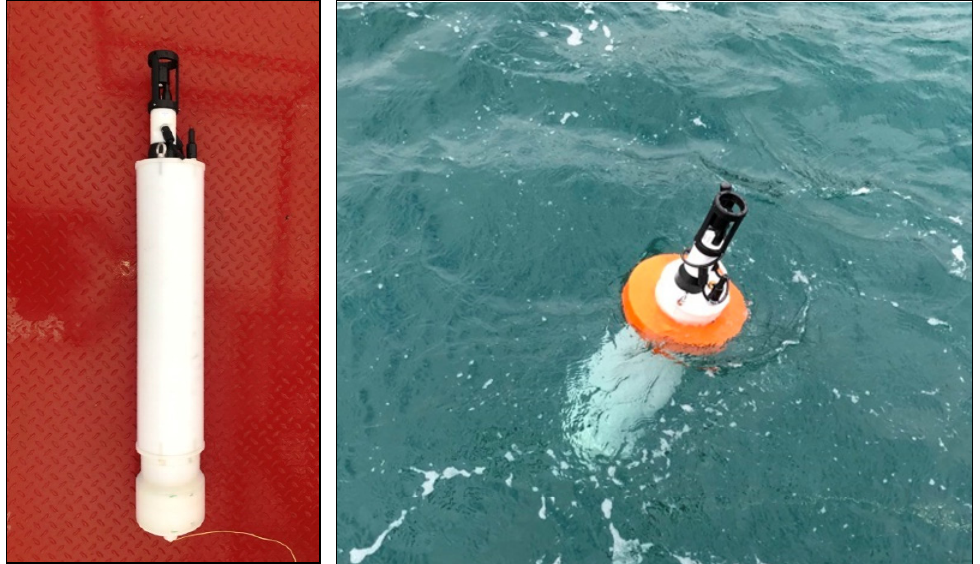
Figure 2. Prototype of the automated tethered profiler ( left ). The prototype profiler pierces the sea surface ( right ). The orange collar is the stabilizing disk. RBRconcerto C.T.D++ is mounted at the upper-end cup.